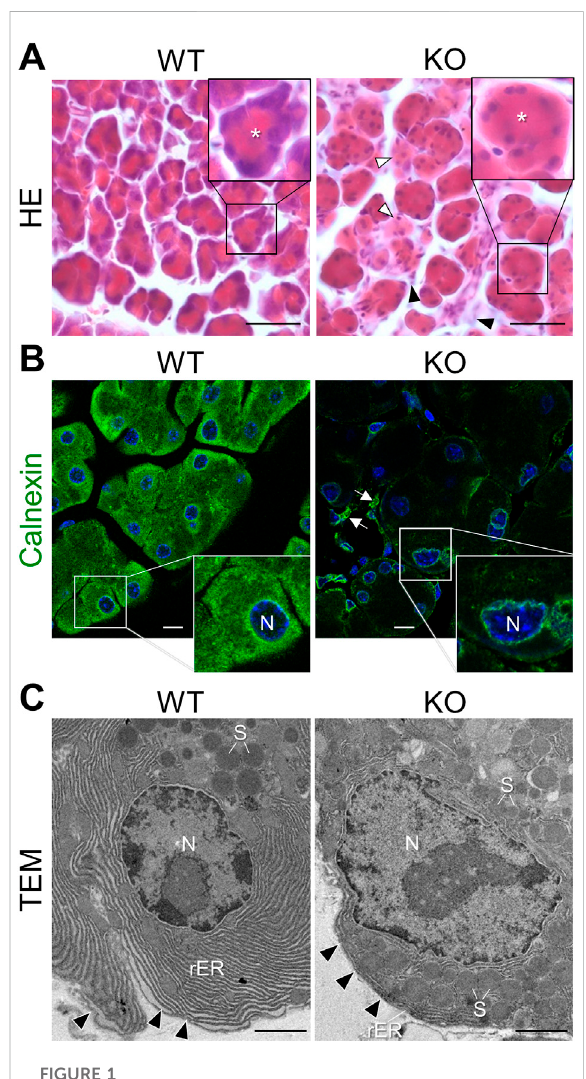
FIGURE 1 Cellular abnormalities in the exocrine pancreas of Cadps2 - KO mice. (A) , HE-stained sections of the exocrine pancreas of WT and KO mice at 8 months of age. The inset in the top right corner shows a magni fi ed view of acinus in each panel. Asterisks in the inset indicate the position of the acinar lumen. Acini of KO do not have suf fi cient hematoxylin-positive basophilic components compared to WT acini. In KO mice, white arrowheads indicate atrophic-like acini and black arrowheads indicate an increase in interstitial cells, such as pancreatic stellate cells and/or in fl ammatory cells. Scale bars: 25 μ m. (B) , Immunostaining of the exocrine pancreas of WT and KO mice. Acinar cells were immunostained for the ER marker calnexin ( green ). DAPI-positive nuclei ( blue ). Inset in the bottom right shows a magni fi ed view of the white square area shown in each panel. Arrows indicate interstitial cells immunopositive for calnexin. N, nucleus. Scale bars:10 μ m. (C) ,ElectronmicroscopyoftheroughER(rER)around the nucleus (N) in pancreatic acinar cells of WT and KO mice at 6 months of age. Arrowheads indicate the basal membrane. S, secretory granule. Scale bars: 1 μ